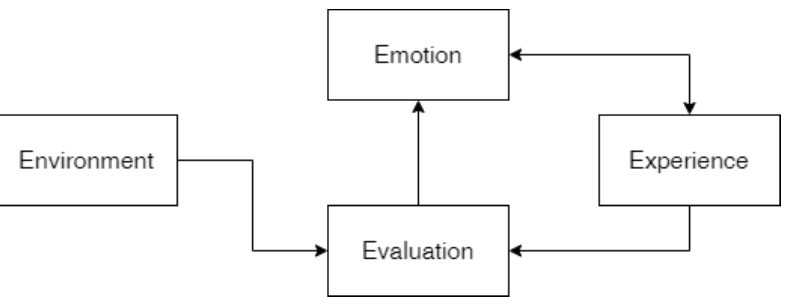
Figure 4. The artificial emotion generation